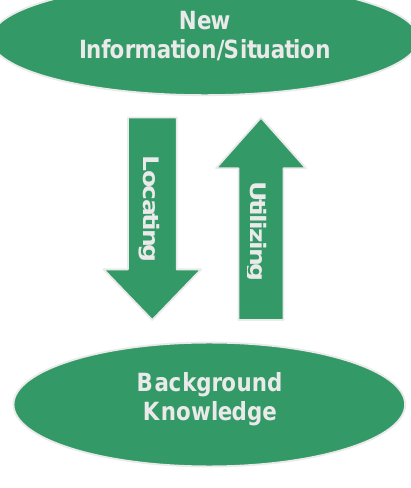
Participants’ Two-way Process of Information Retrieval